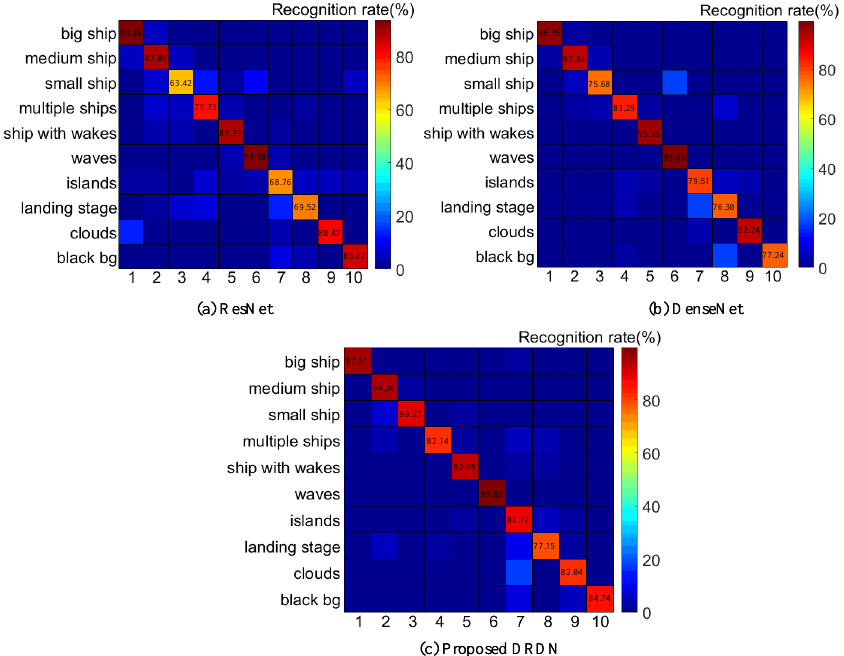
Figure 13. Recognition rate matrices of different classification networks. Numbers 1–10 in the horizontal axis correspond to the category names in the vertical